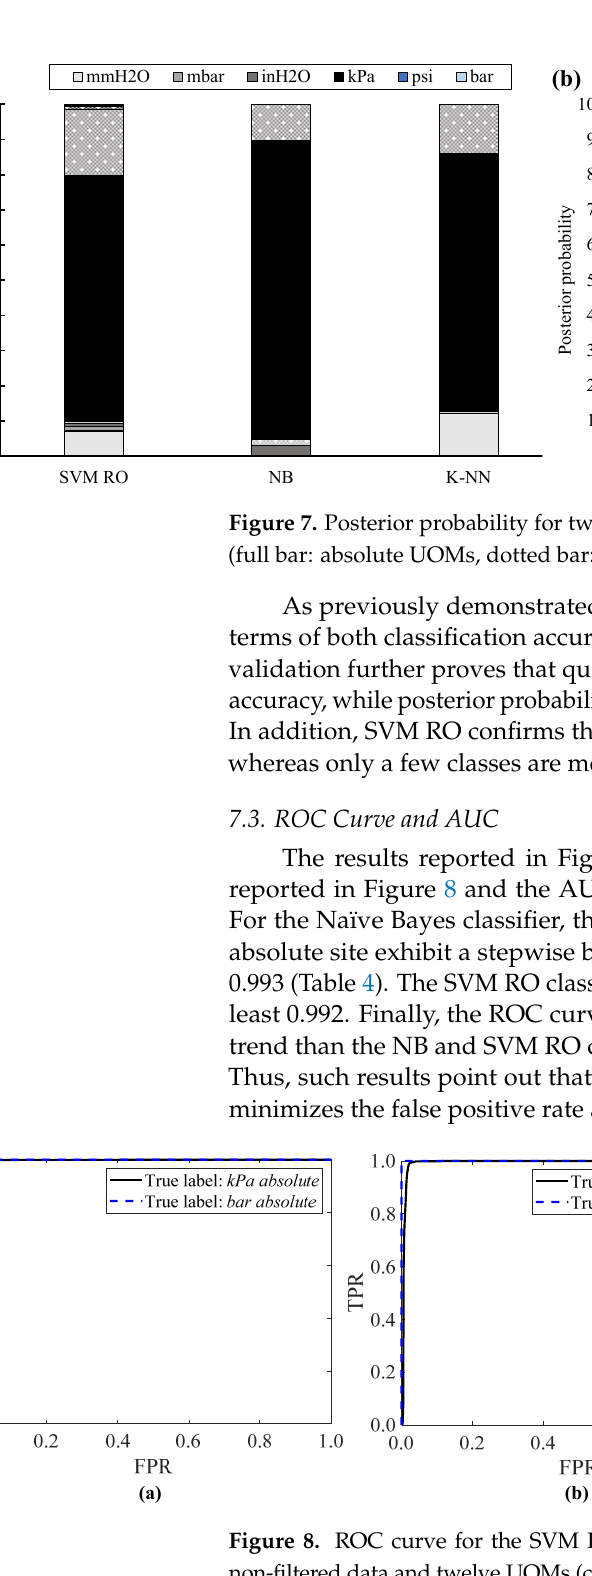
14 of 20 Figure 6. Posterior probability for twelve UOMs: training with 10% of non-filtered data (full bar: absolute UOMs, dotted bar: gauge UOMs; kPa absolute sites ( a ), bar absolute site ( b )). Similarly, psi absolute and kPa absolute are the second and third-most probable la- bels, respectively, for Site #11. Instead, for the NB classifier, posterior probability of each class strictly depends on its proximity to the true UOM. In fact, for Site #1 through #10, posterior probability of inH 2 O absolute, mbar absolute, inH 2 O gauge, and kPa gauge is higher than the one of the other UOMs. Similarly, for Site #11, posterior probability of all UOMs is null, with the exception of bar gauge and psi gauge. The K-NN classifier identifies the correct UOM among a limited number of labels. In fact, for Site #1 through #10, posterior probability of four classes only is not null, i.e., mmH 2 O absolute, inH 2 O gauge, mbar gauge, and kPa absolute (the true UOM). This out- come can be explained by considering that wrongly assumed mmH 2 O absolute data ap- proximately overlap data that are correctly labeled as kPa absolute. In addition, the inH 2 O gauge and mbar gauge labels are the classes that are nearest and second-nearest to the true UOM (see Figure 3). A similar result is confirmed for Site #11, in which the kPa abso- lute label is the only incorrect UOM whose posterior probability is not null. In fact, wrongly assumed kPa absolute data numerically overlap data correctly labeled as bar ab- solute.